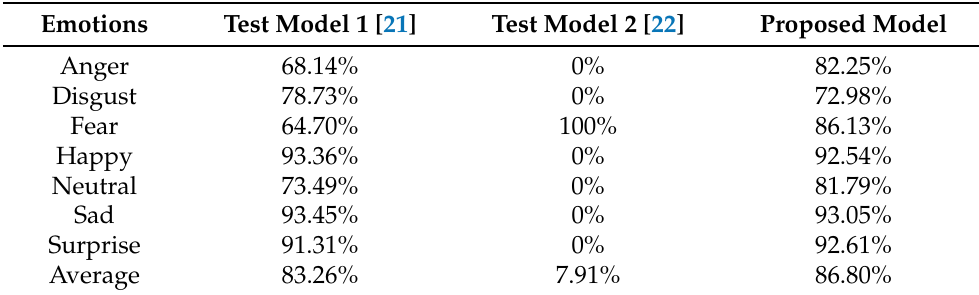
Table 11. Comparison of emotion prediction by Model 1, Model 2, and proposed model for experi- ment 1 after 10 epochs.